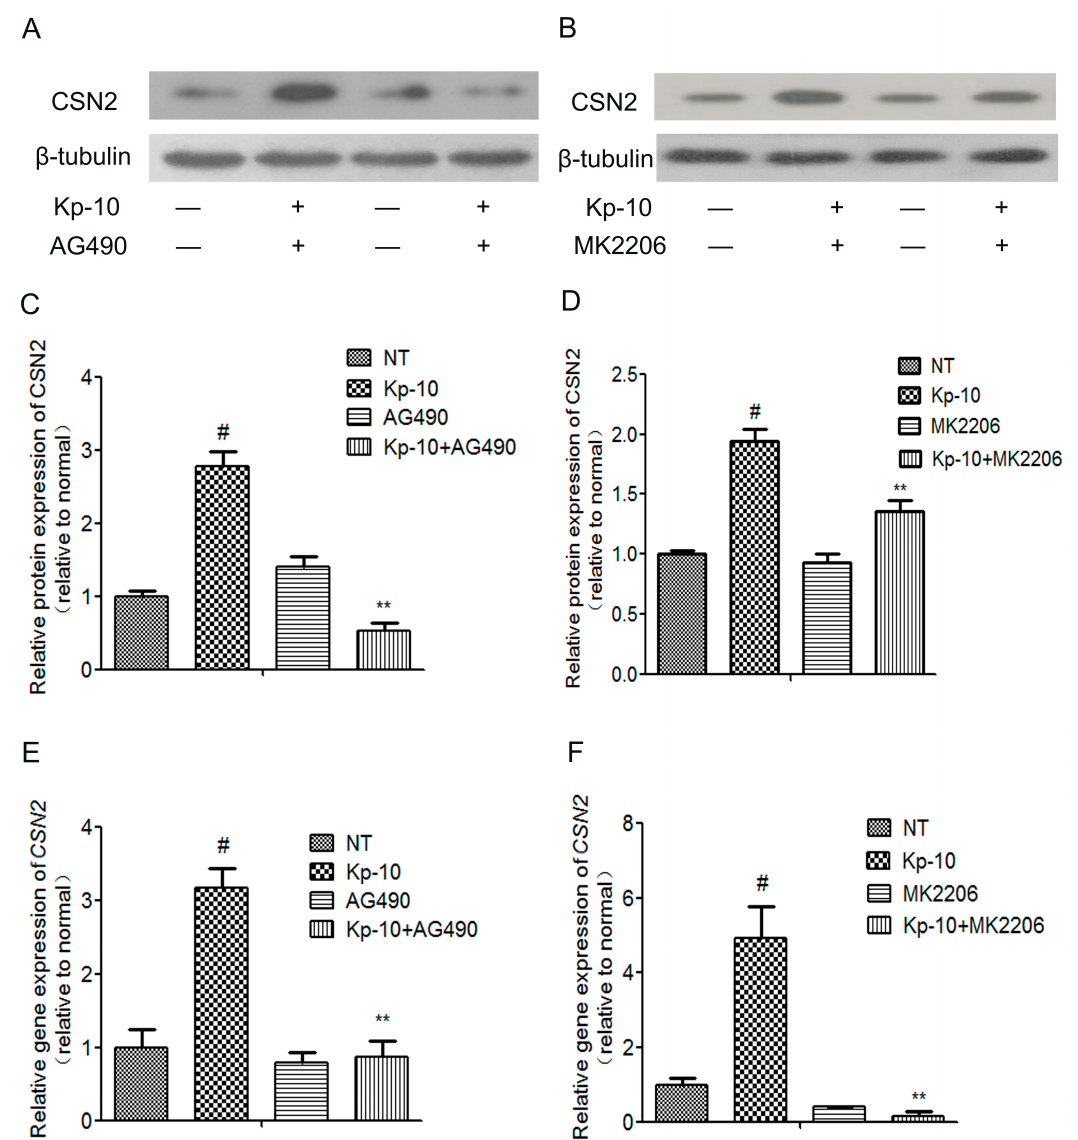
Figure 7. The STAT5 inhibitor AG490 and the AKT inhibitor MK2206 attenuated the Kp-10-induced increased the gene and protein expression of CSN2 in bMECs. The cells were pre-treated for 1 h with AG490 (50 µ M) or MK2206 (10 µ M) and then incubated for 12 h with Kp-10 (100 nM). The protein ( A – D ) and gene ( E , F ) expression of CSN2 was examined by Western blot and quantitative real-time PCR. The data is presented as the means ± S.D. ( n = 3; # p < 0.01 vs. NT; ** p < 0.01 vs. Kp-10 treatment).